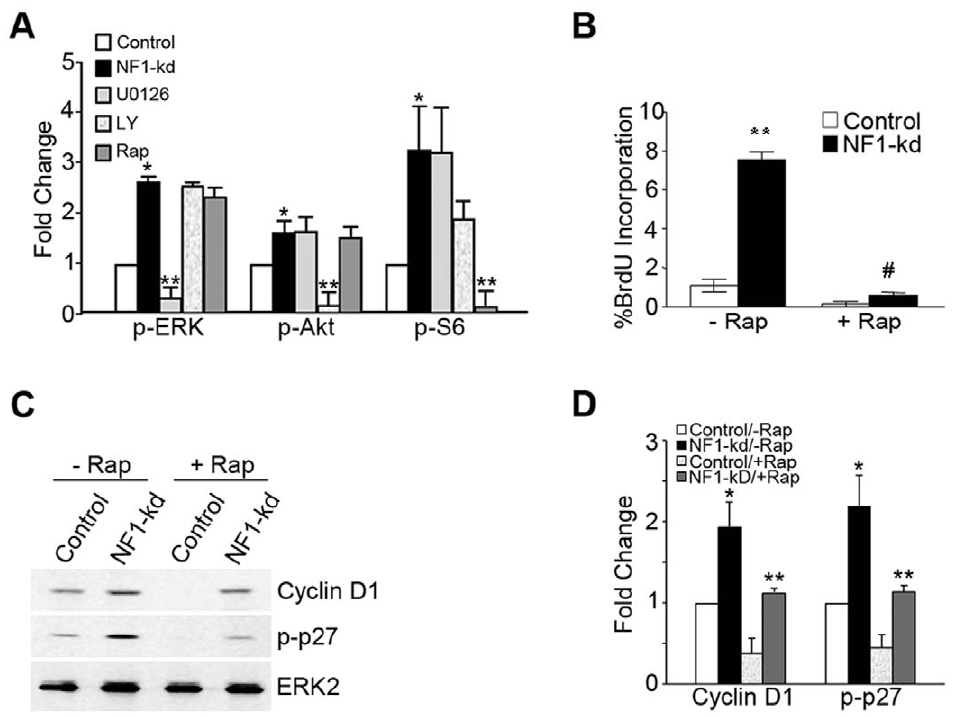
Figure 6. mTORC1 is critical for enhanced proliferation following the loss of NF1 (pSIREN). Control and NF1 knockdown primary endothelial cells were serum deprived for 24 h prior. Inhibitors were added was added at the time of serum starvation at the following concentrations (U0126, 1 m M; LY29002, 100 nM; Rapamycin, 0.1 ng/ml). At 21 h, some cells were pulsed with BrdU for 3 h. At 24 h cell lysates were made and probed for changes in cellular signaling (A) using phospho-specific antibodies or changes in cellular proliferation (B), visualized with an anti-BrdU antibody. (A) Results from three independent experiments were quantified from western blots similar to those shown in Supplemental 2. Data represent band average response under each condition. Error bars represent standard error of the mean and relevant statistical relationships are shown (*p , 0.05 compared to Control; **p , 0.01 compared to NF-kd. (B) BrdU positive cells were quantified and the data was graphed as the % positive cells compared to total cell number. The error bars represent standard error of the mean (**p , 0.01 compared to control; # p , 0.01 compared to NF1-kd). In a similar experiment, cells was serum starved 24 h in the absence and presence of rapamycin (0.1 ng/ml) and lysates were made and probed with antibodies against cyclin D1, phospho-p27 and ERK2, the latter used as a loading control. (D) Results from three experiments similar to those performed in (C) were quantified. Data represents the mean result. Error bars represent standard error of the mean (*p , 0.05 compared to control; **p , 0.01 compared to